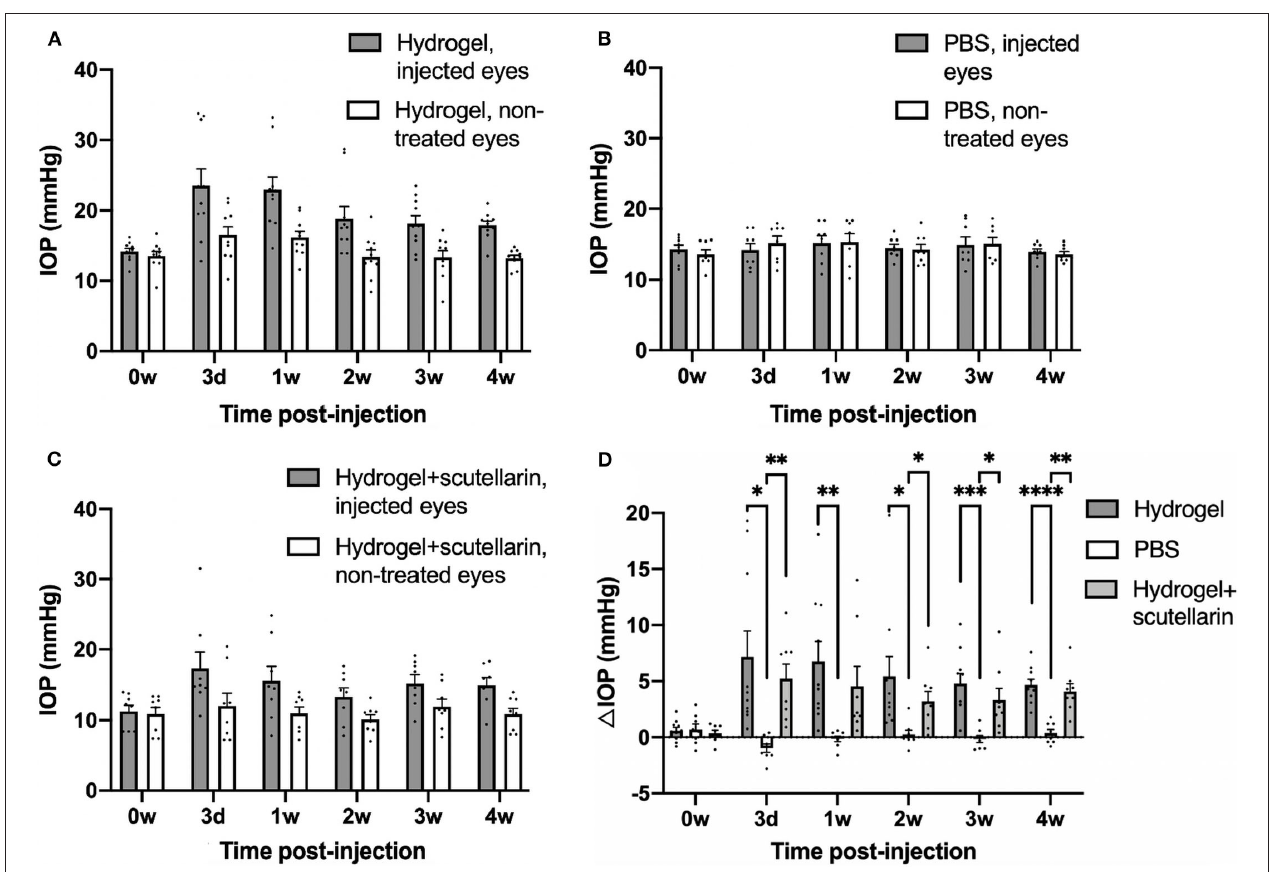
FIGURE 1 | Intraocular pressure (IOP) profiles after unilateral intracameral injections in adult C57BL/6J mice. IOP values of both injected (gray bar) and contralateral, non-treated eyes (white bar) are shown in the hydrogel-only group (Group 1) (A) , phosphate-buffered saline (PBS) group (Group 2) (B) and hydrogel + scutellarin group (Group 3) (C) . Hydrogel-injected eyes in both Groups 1 and 3 (A,C) developed sustained elevation of IOP relative to the non-treated eyes (ANOVA, p < 0.05), while the PBS-injected eye in Group 2 did not differ in IOP levels from the non-treated eye (ANOVA, p > 0.05). (D) The inter-eye IOP difference ( 1 IOP, injected minus non-injected eye) was significantly higher in both the hydrogel-only group (dark gray bar) and the hydrogel + scutellarin group (light gray bar) when compared to the PBS group (white bar), but was not significantly different between hydrogel-only and hydrogel + scutellarin groups. 0w: 0 week, pre-injection; 3d: 3 days post-injection; 1w to 4w: 1 week to 4 weeks post-injection. Data were represented as mean ± SEM. Post-hoc Tukey’s multiple comparisons correction tests between groups in (D) : * p < 0.05, ** p < 0.01, *** p < 0.001, **** p <